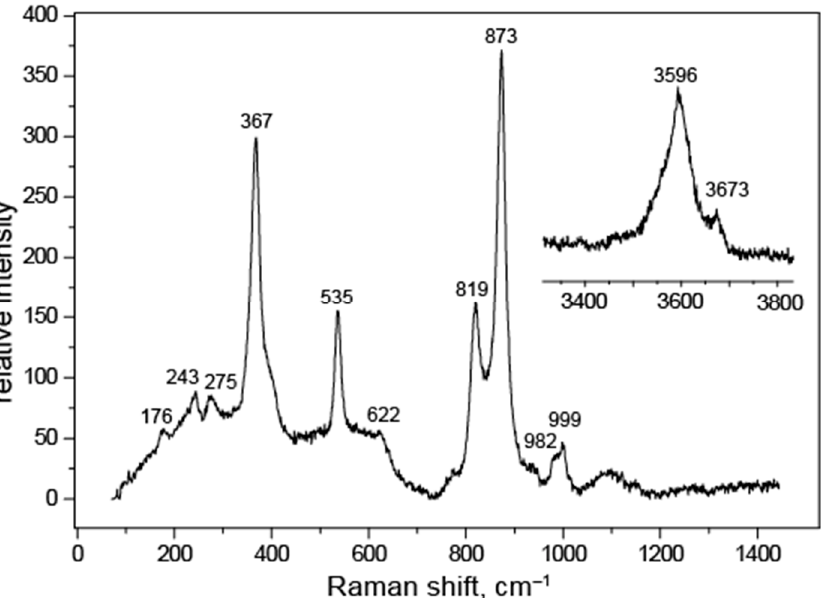
Figure 2. Raman spectrum of (H 4 O 4 ) 4 − -substituted grossular from the Wiluy River, Yakutia, Russia. The bands in the region of 3400–3800 cm − 1 (Figure 2) correspond to the stretching vibrations of the OH groups. The deficit of Si in garnet composition (Table 1) together with observed bands in this region confirms the presence of hydrogarnet-type defects (H 4 O 4 ) 4 − in grossular with a prismatic habit from the Wiluy River, Yakutia, Russia. The band at 3673 cm − 1 may be also related to the OH groups in the thin crusts of clinochlore on grossular